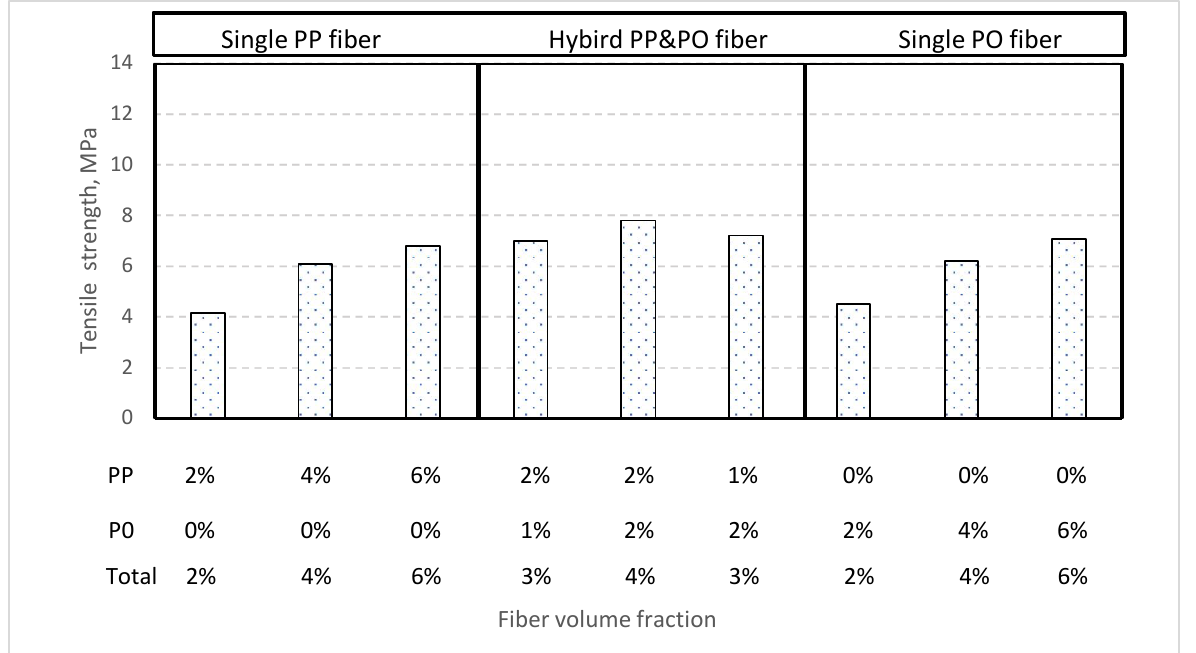
Figure 15. Effect of lightweight fiber hybridization on 28-day concrete tensile strength.